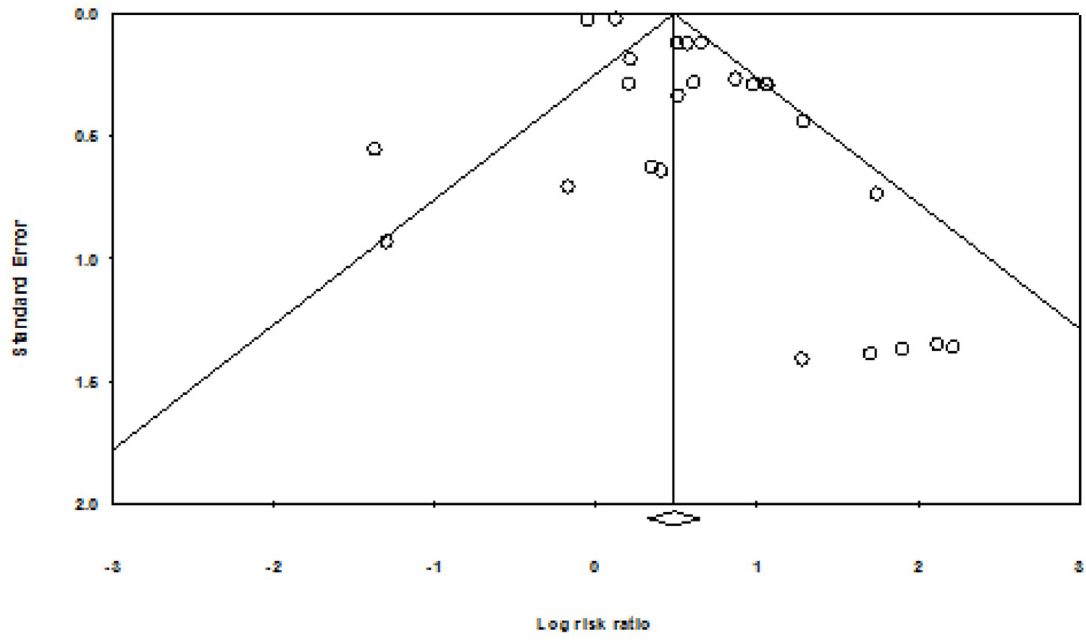
Figure 17. Contour enhanced funnel plot, all behaviours (latest follow-up point).